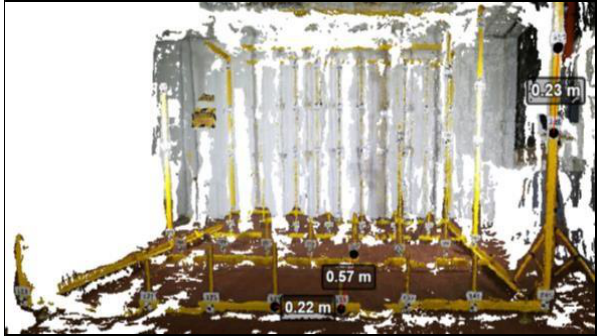
Figure 9 The distance between two markers in X, Y and Z